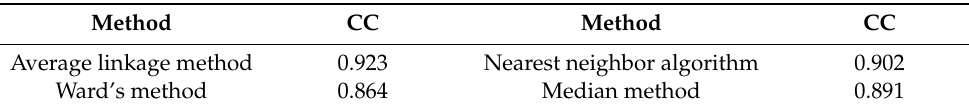
Table 5. Cophenetic correlation coe ffi cient (CC) values.